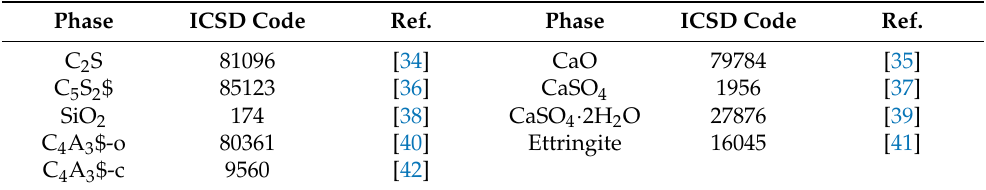
Table 4. ICSD collection codes and references for all phases used in the Rietveld quantitative phase